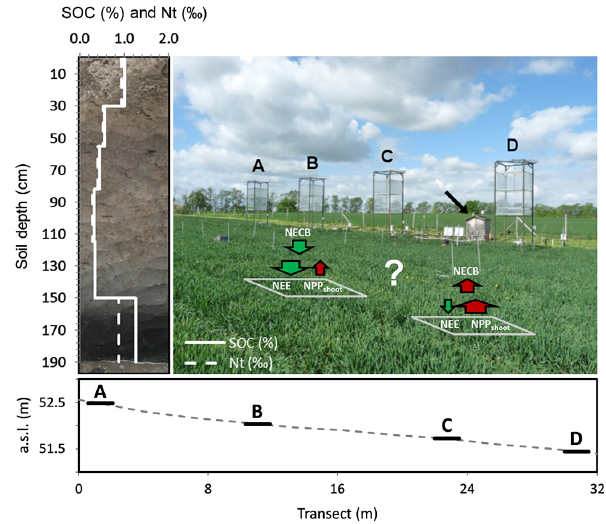
Figure 2. Transect of automatic chambers and chamber positions within the depression overlying the Endogleyic Colluvic Regosol (WRB 2015, left). The black arrow shows the position of the data logger and controlling devices, which were placed within a wooden, weather-sheltered house. The soil profile is shown on the left. Soil horizon-specific SOC (%) and Nt (%) contents are indicated by solid and dashed vertical white lines, respectively. Spatial differ- ences in NECB and the basic principle of the C budget method are shown as the scheme within the